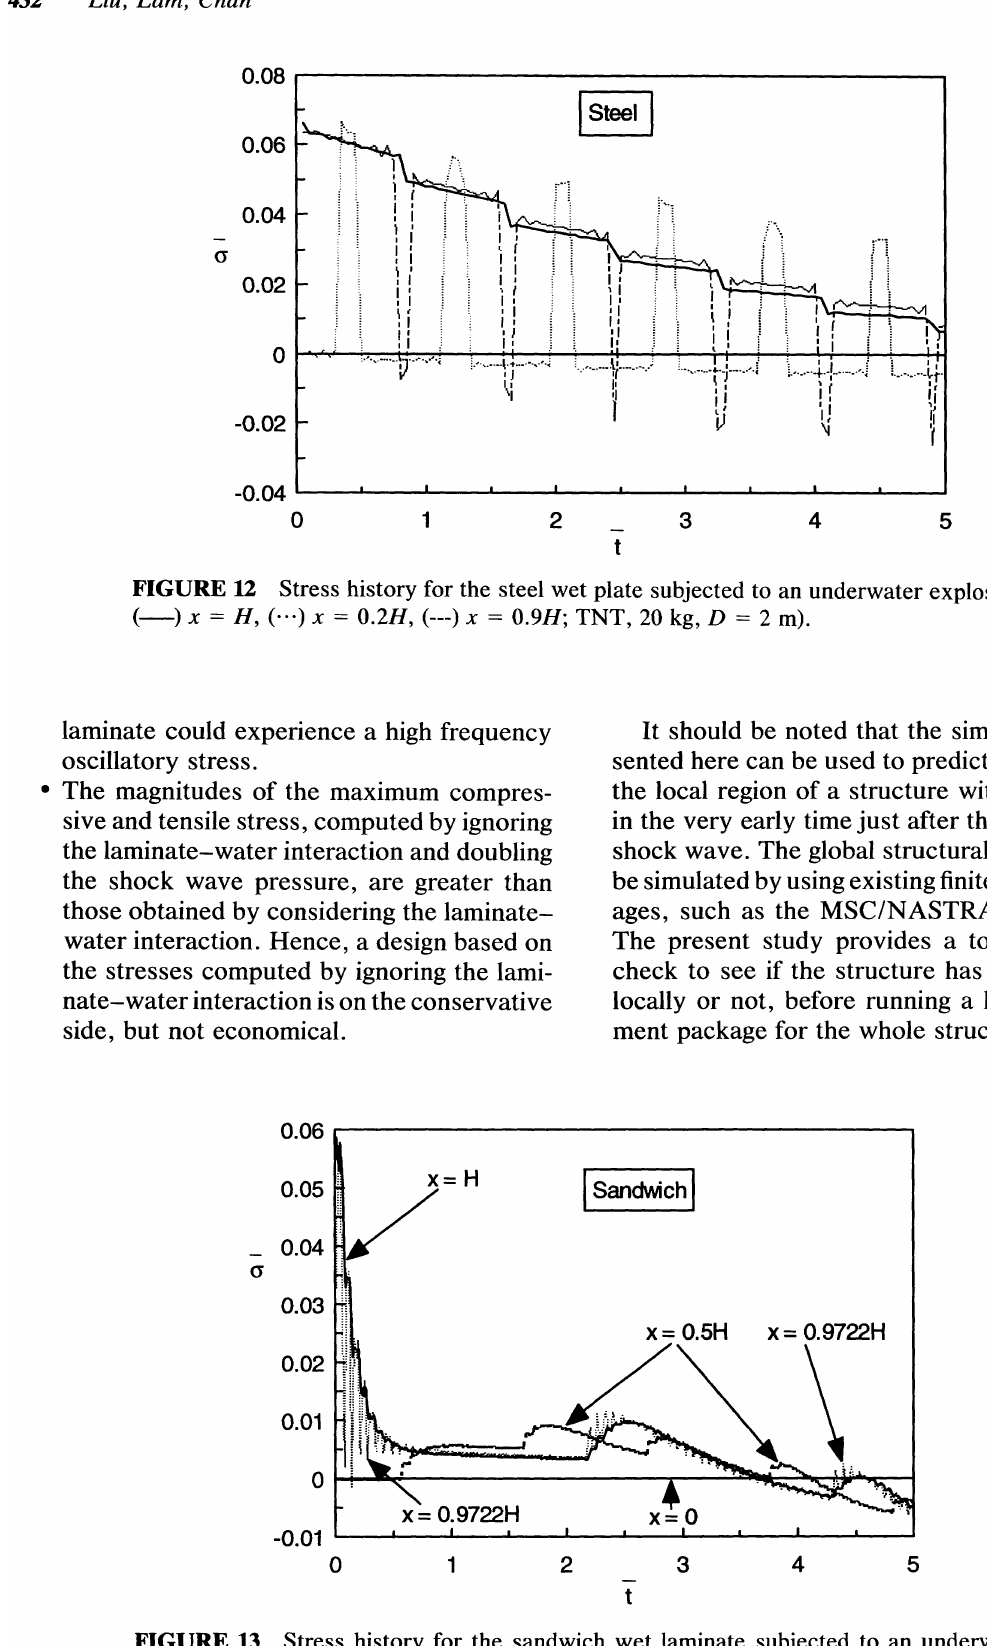
FIGURE 13 Stress history for the sandwich wet laminate subjected to an underwater explosion. TNT, 20 kg, D = 2